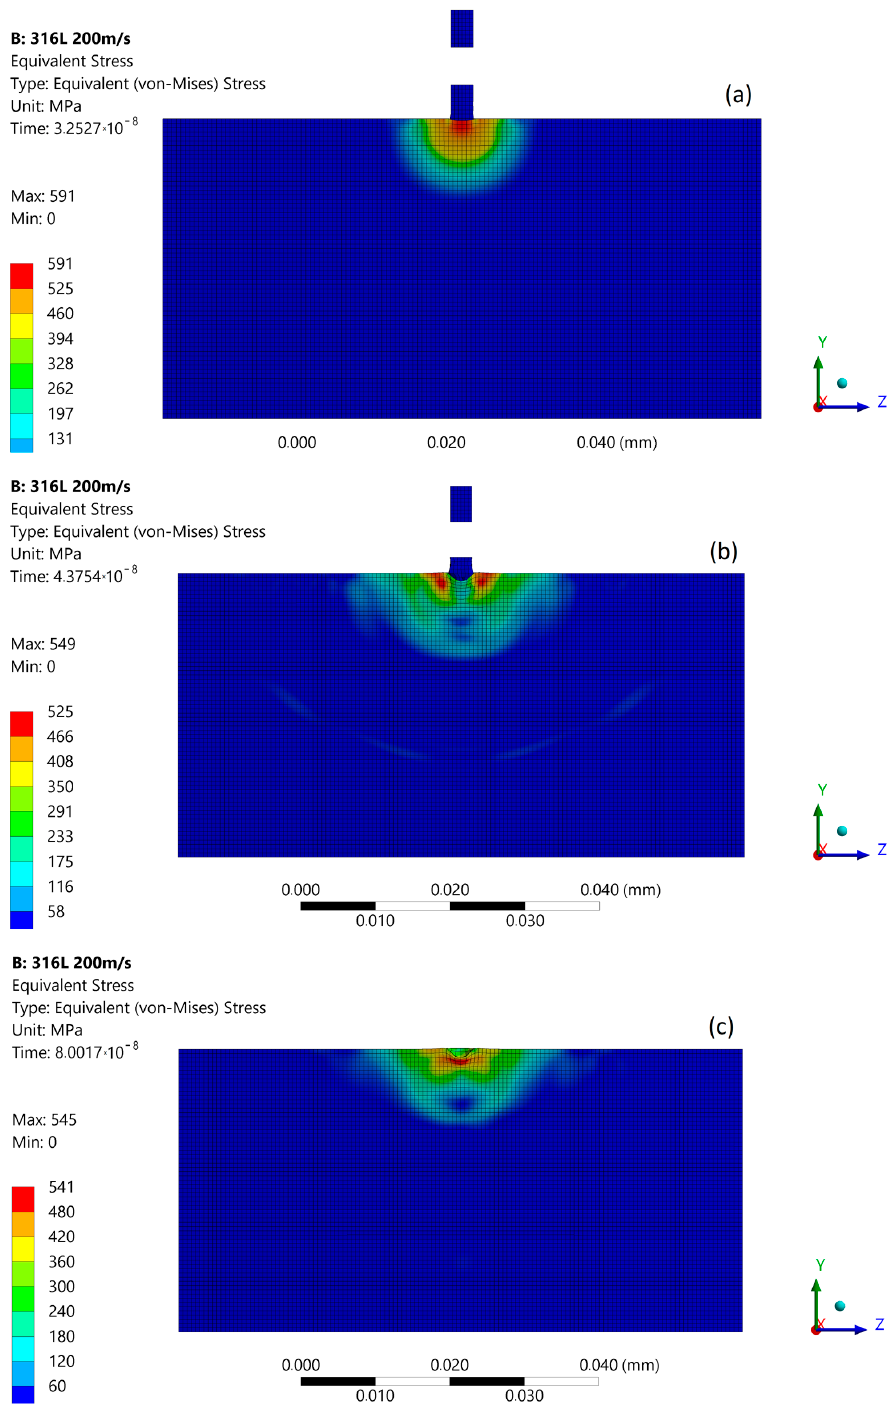
Figure 9. Von Mises stress distribution during first micro ‐ jet impact at 200 m/s: ( a ) initial stage of the impact; ( b ) stage during the impact; ( c ) residual stress after the impact. impact; ( b ) stage during the impact; ( c ) residual stress after the